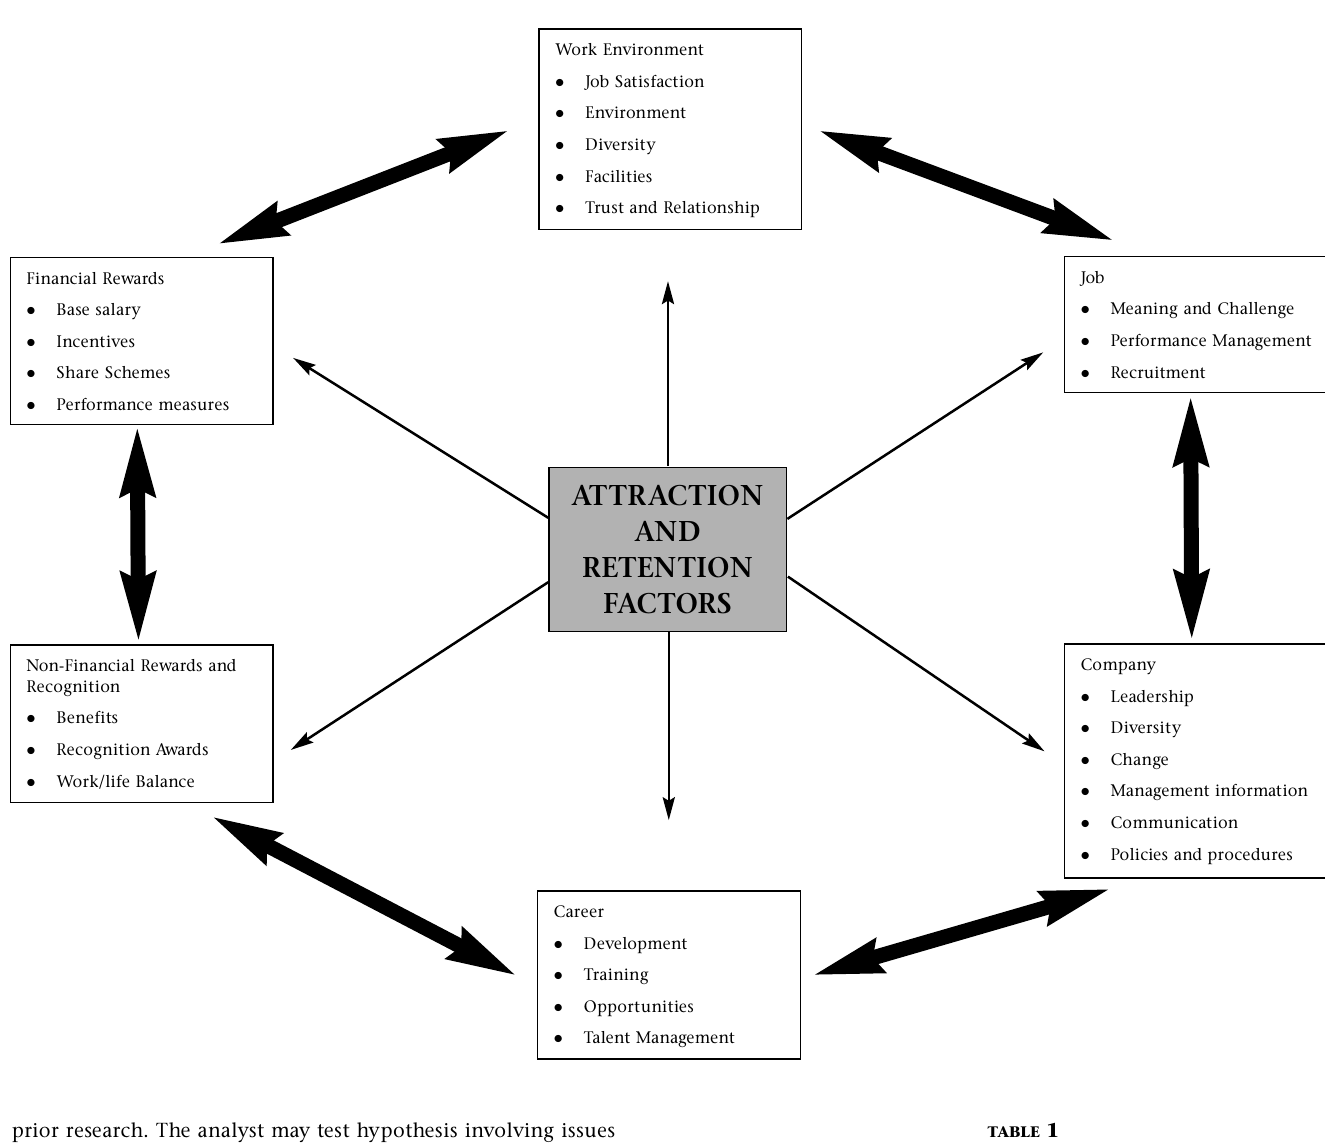
F IGURE 1: F RAMEWORK FOR BEST COMPANIES TO WORK FOR